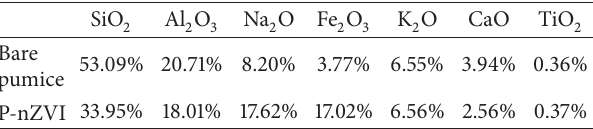
Table 3: Oxide composition of bare and P-nZVI using XRF